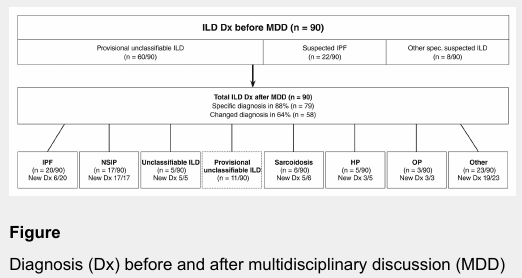
Diagnosis (Dx) before and after multidisciplinary discussion (MDD) for interstitial lung disease (ILD). IPF = idiopathic pulmonary fibrosis; NSIP = nonspecific interstitial pneumonia; HP = hypersensitivity pneumonitis; OP = organising pneumonia. Other diagnosis (1–2 cases each) included: combined pulmonary fibrosis and emphysema, Langerhans cell histiocytosis, vasculitis, respiratory bronchiolitis ILD, pulmonary lymphangioleiomyomatosis, Birt-Hogg-Dubé syndrome and diffuse idiopathic pulmonary neuroendocrine cell